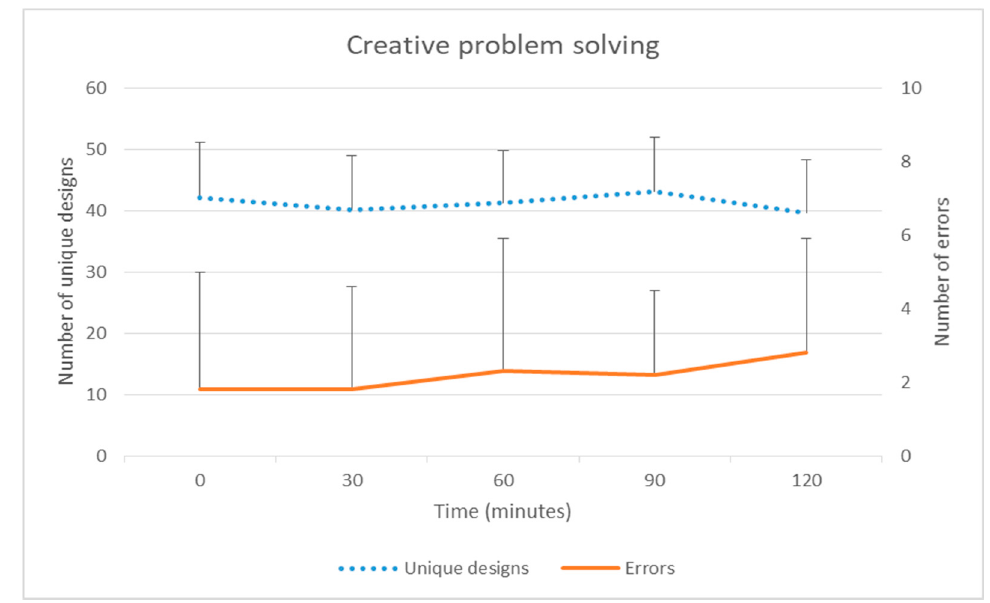
Figure 3. Mean (+standard error) creative problem solving (unique designs and errors) over two hours of prolonged sitting (non transformed).